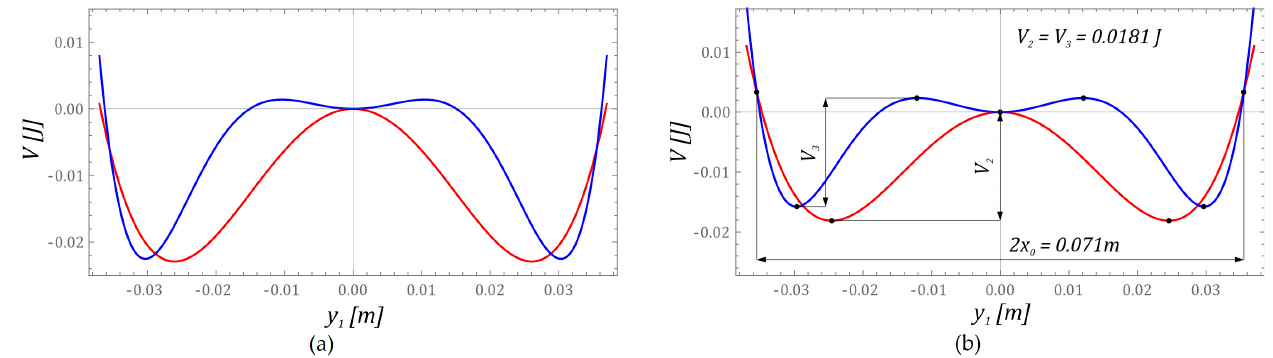
Figure 4. Potential characteristics of energy harvesting systems caused by: ( a ) magnetic field of distributed permanent magnets (Figure 1), and ( b ) magnetic field effect as in the previous case and an additional change in the stiffness of the flexible cantilever beam (to satisfy equal potential barriers, V 2 = V 3 ) used in further calculations.